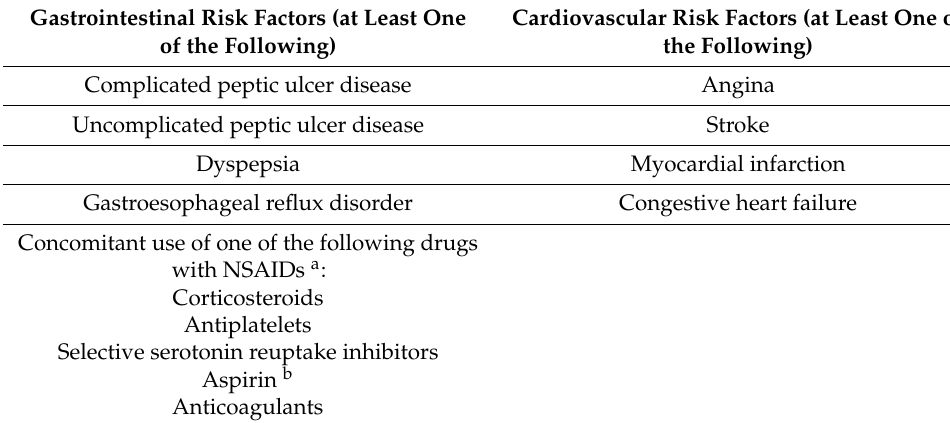
Table 1. Identification of High Risk Older Adults